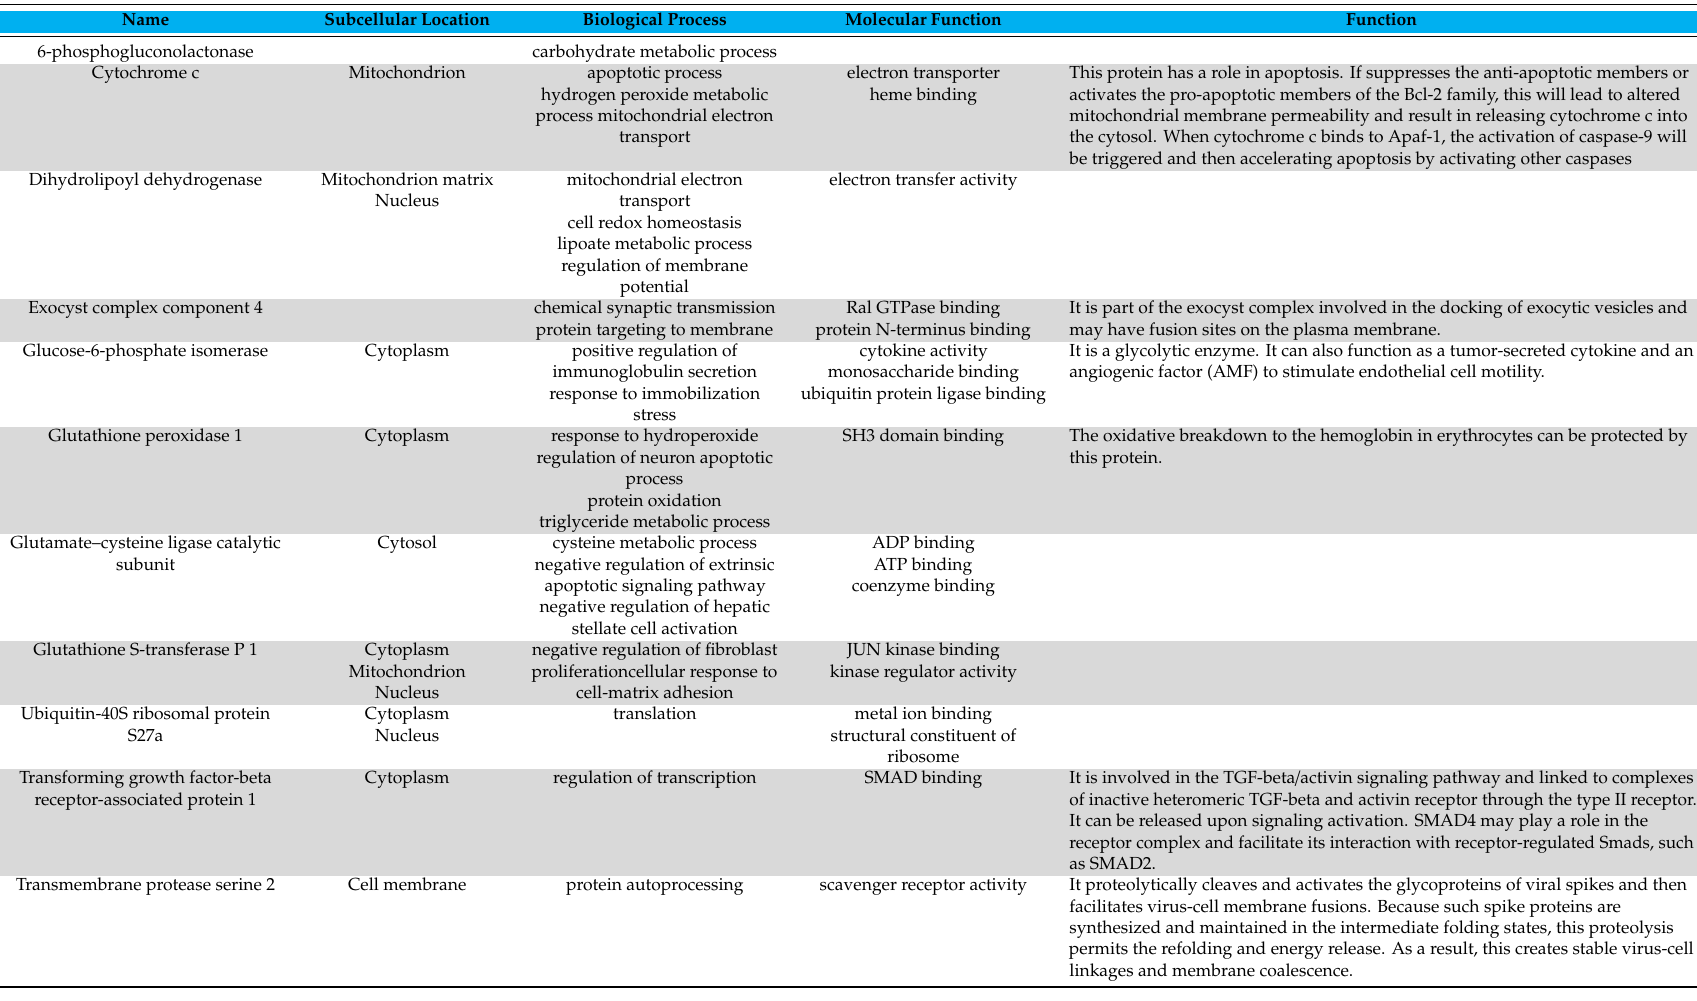
Table 4. Summary of protein function corresponding to HBV